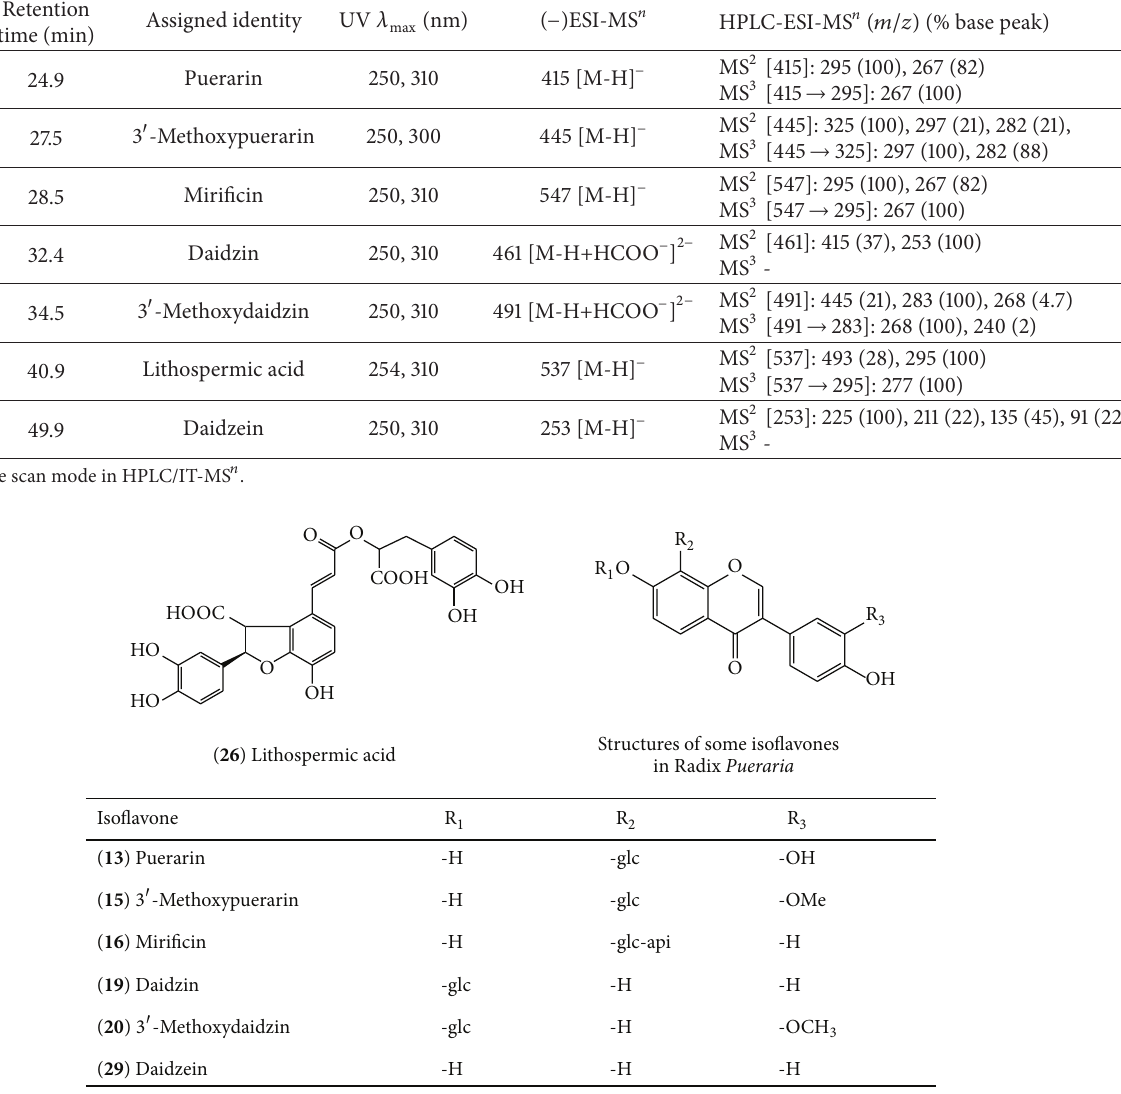
Figure 7: Chemical structures corresponding to seven common